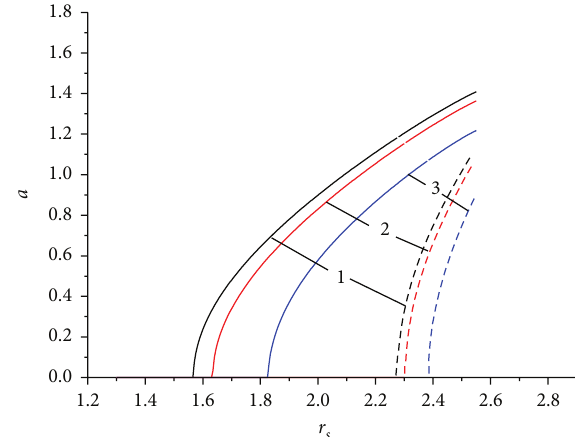
Figure 4: Frequency response for primary parametric resonance. Dashed lines are unstable. Line 1: no fast excitation; line 2: 𝐸 22 ⋅ 𝑟 𝑓 = 0.3; line 3: 𝐸 22 ⋅ 𝑟 𝑓 = 0.6.